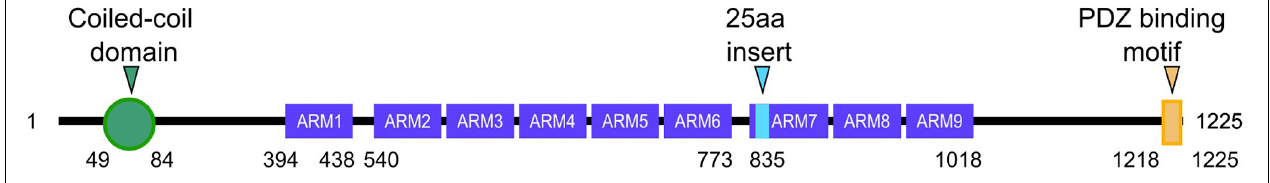
FIGURE 1 | Schematic of delta-catenin protein structure. The structures include a coiled-coil domain (green), 9 armadillo (ARM) repeats (purple), and a PDZ binding motif (yellow). An alternative splicing insert that is 25 amino acids in length is in the 7th ARM repeat (cyan). The amino acid number corresponding to where each domain is listed below. Amino acids corresponding to small gaps between ARM domains are not